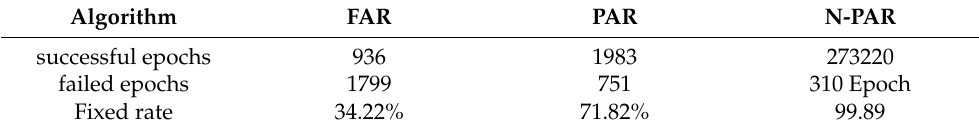
Table 2. Fixed rate statistics of each algorithm.